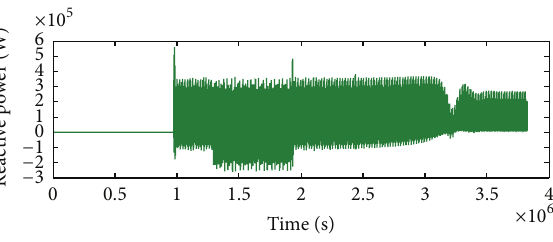
Figure 15: Reactive power during LLG fault.